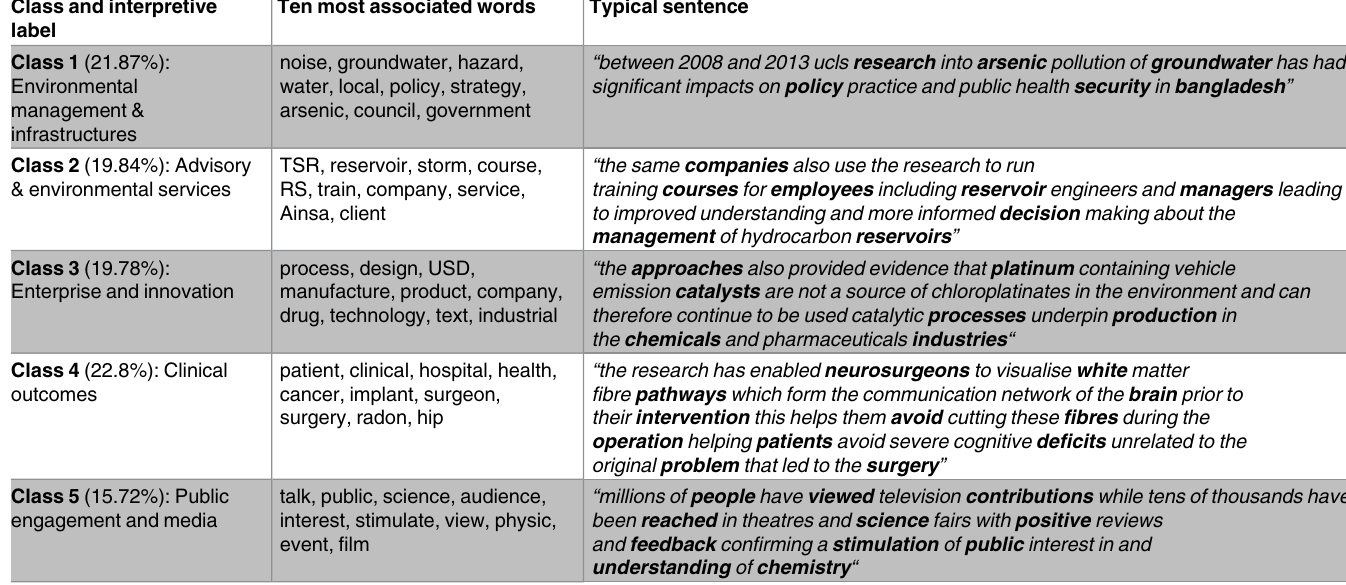
Table 5. Panel B–Physical